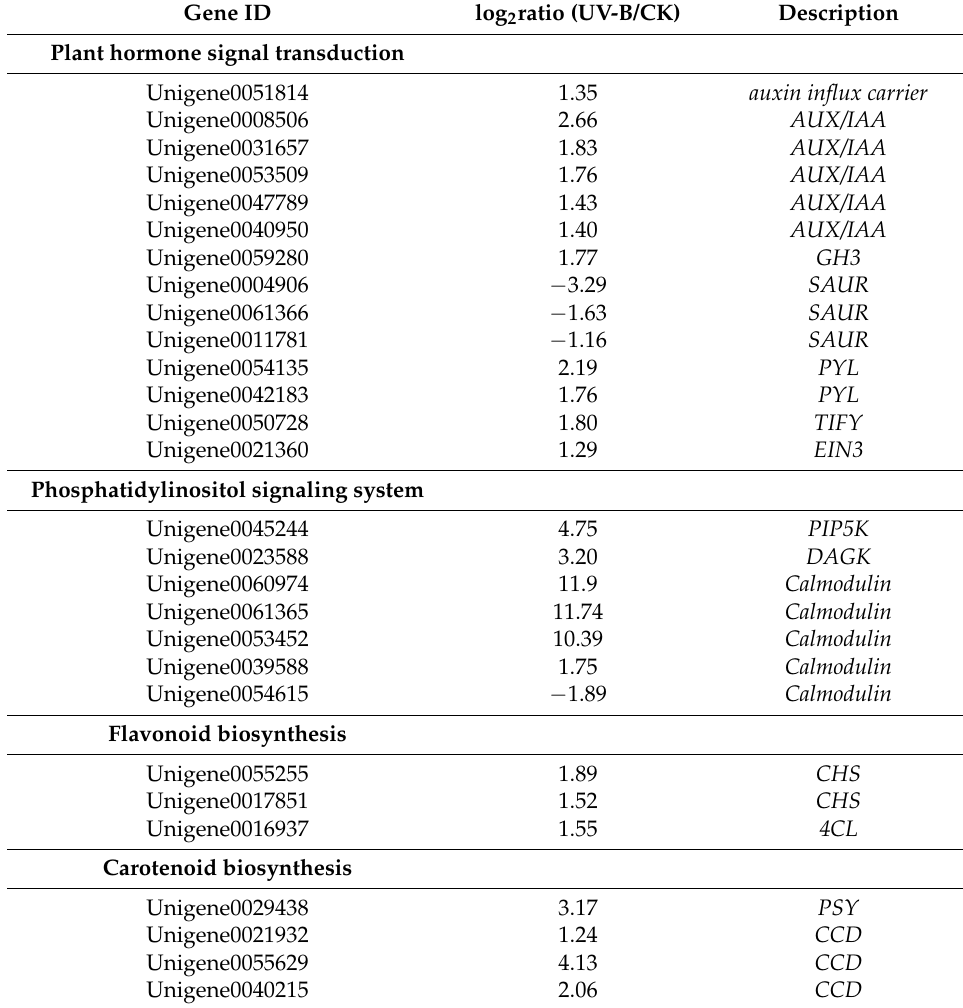
Table 2. A list of some important genes that are differentially expressed between UV-B and CK, and are involved in plant hormone signal transduction, phosphatidylinositol signaling system, flavonoid biosynthesis and carotenoid